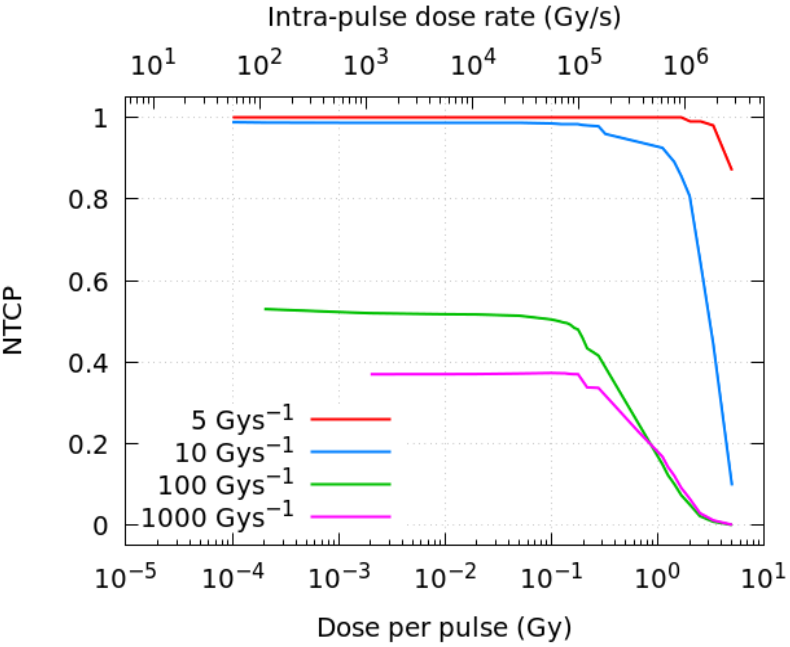
Figure 4. NTCP as a function of the dose per pulse and the intra-pulse dose rate for different average dose rates of radiation. All the simulations correspond to a total dose of 10 Gy.